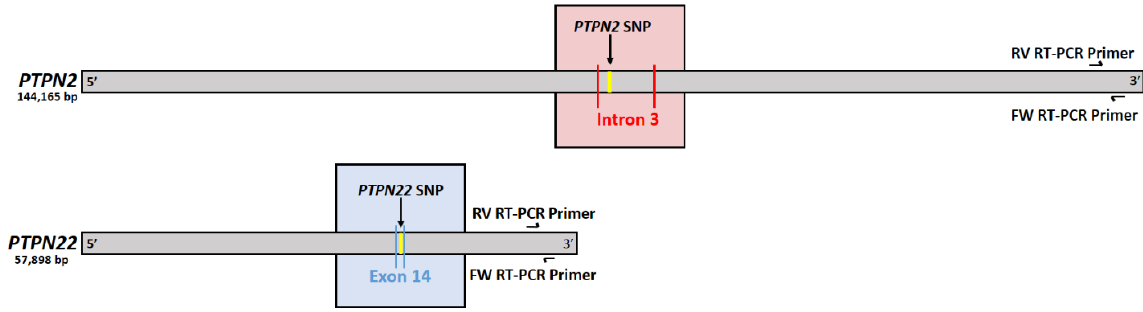
Figure 2. PTPN2/22 Gene Maps with Relative SNPs and RT-PCR Primer Locations.